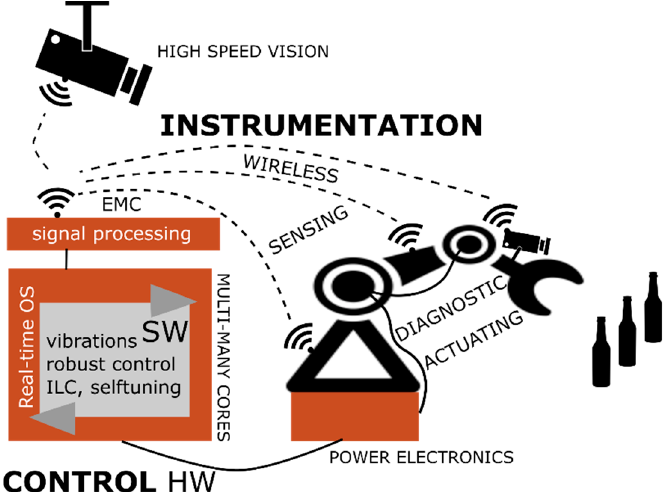
Figure 1. Selected KETs (key enabling technologies) for advanced mechatronic applications that require fast high-level adjustment and adaptation; they are further represented by BBs in Section 4.